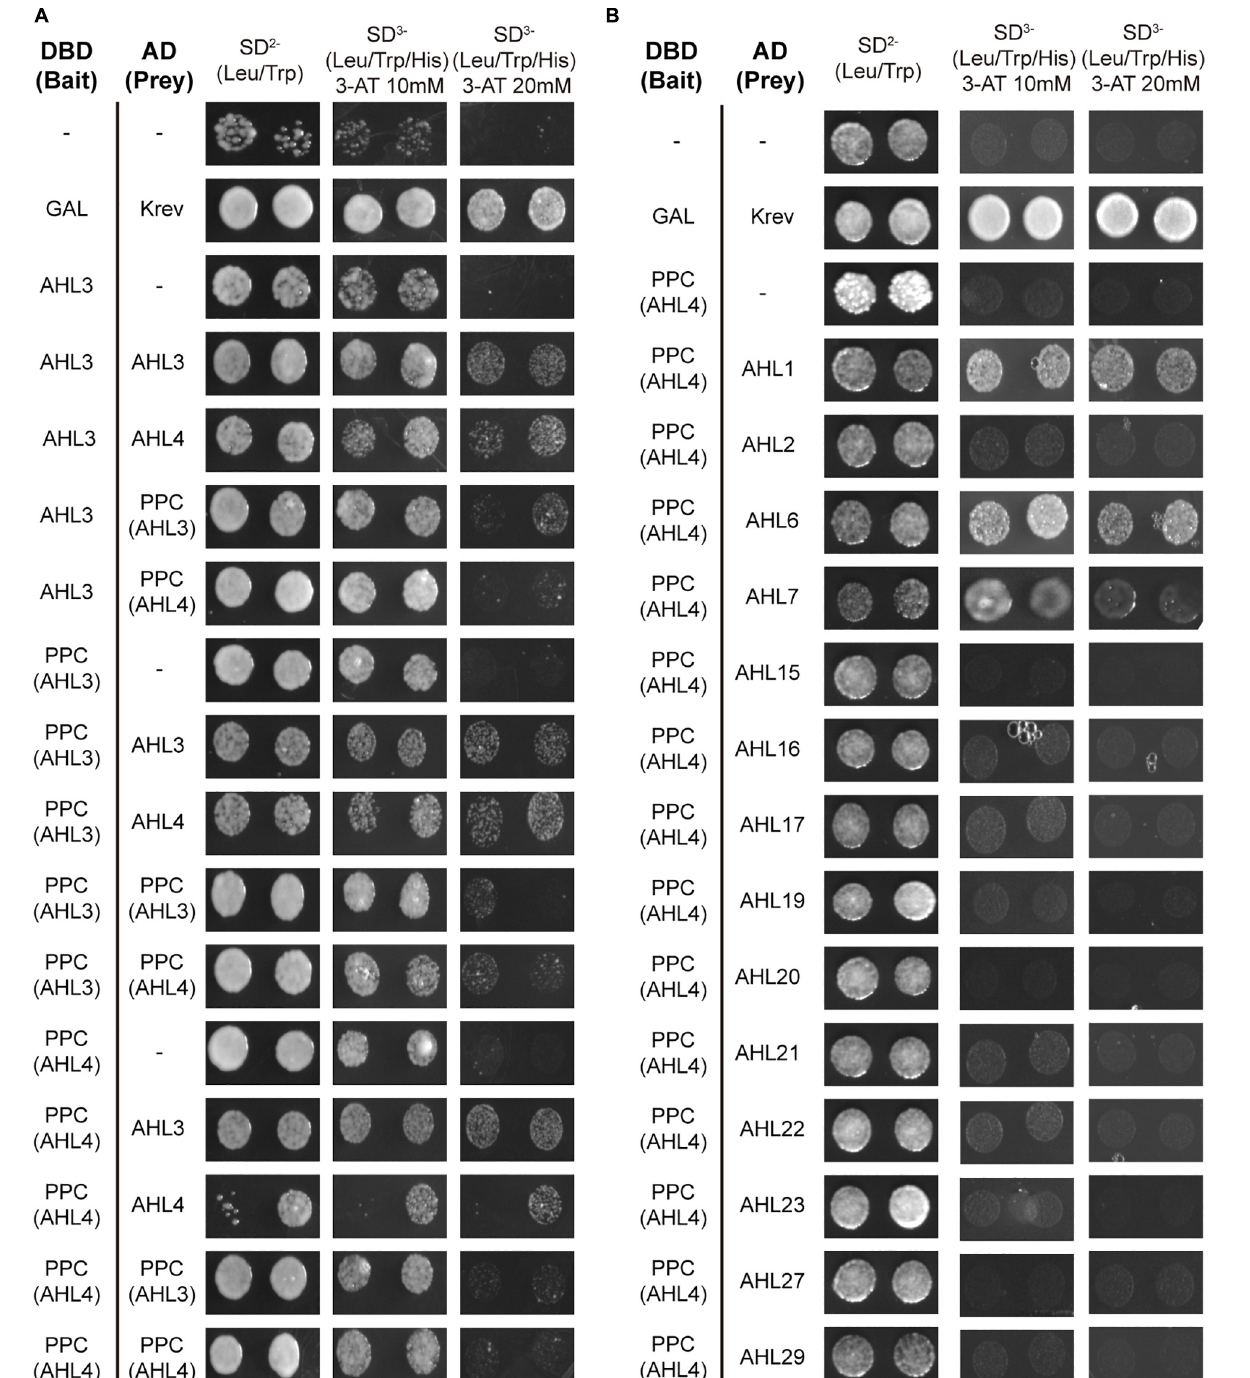
Frontiers in Plant Science |